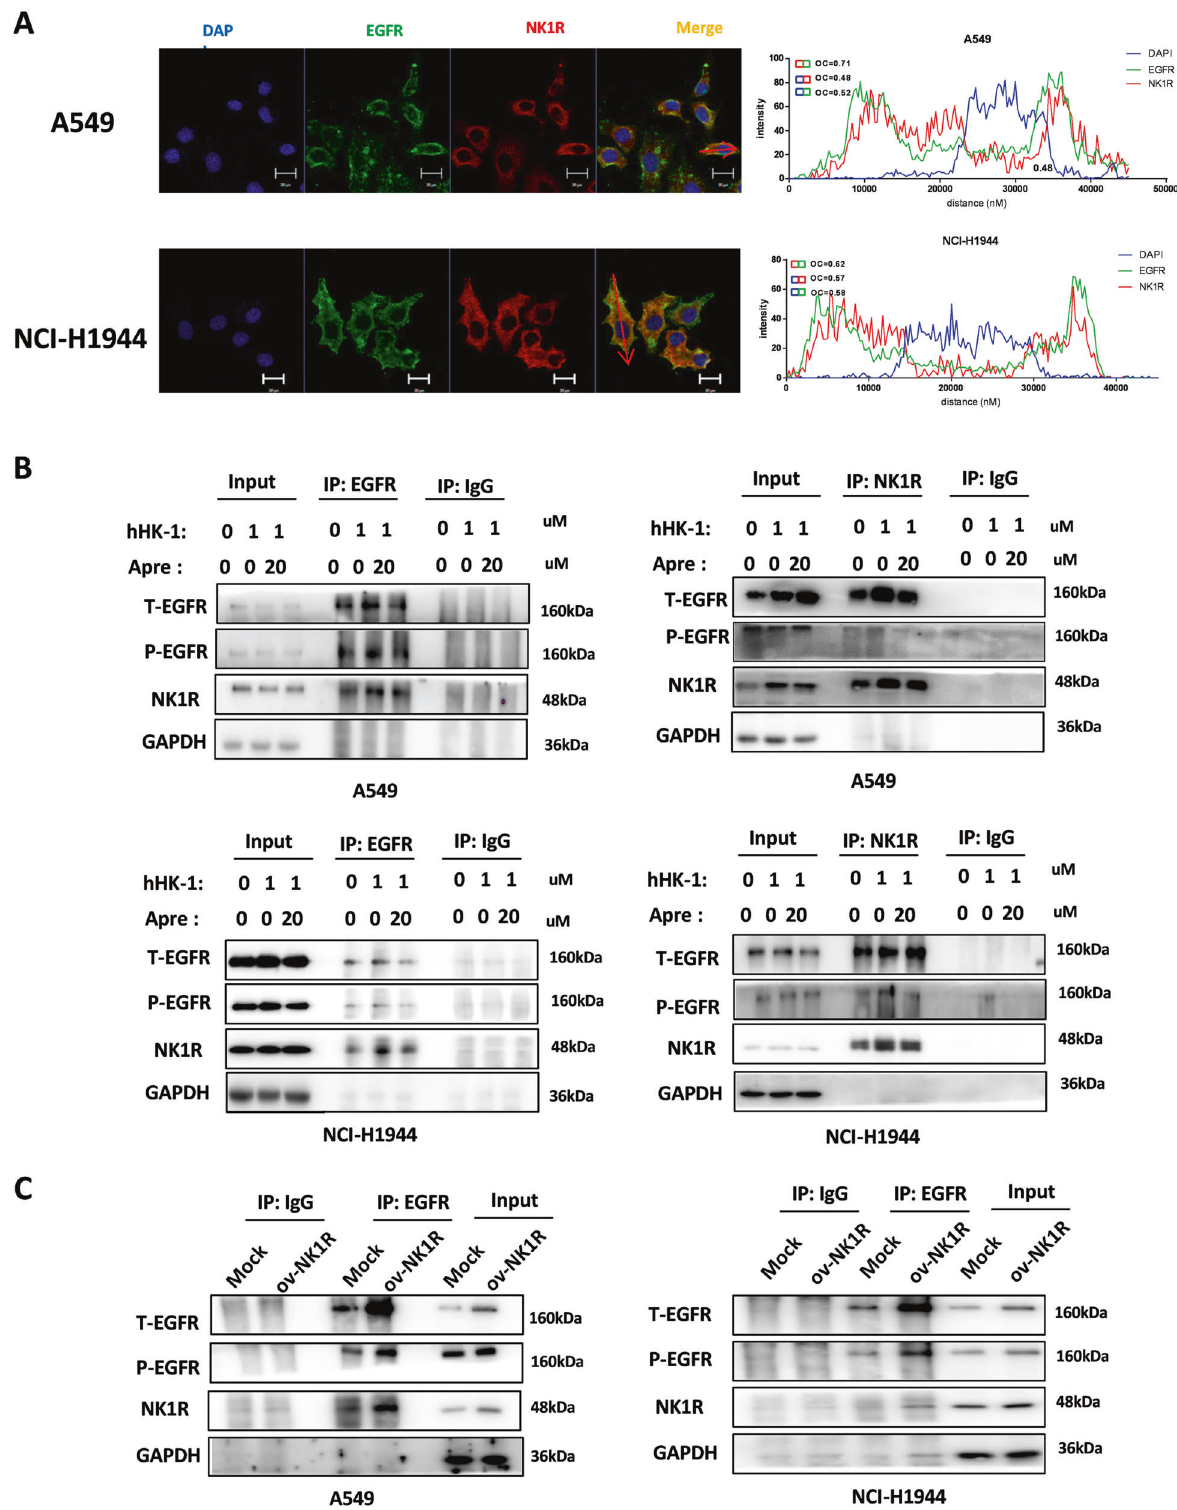
Fig. 6 NK1R interacts with EGFR in NSCLC cells. A Confocal microscopy analysis to detect the colocalization of EGFR and NK1R in A549 and NCI-H1944. Green, EGFR; Red, NK1R; nucleus was stained by DAPI. Scale bar, 20 μ m. The plot pro fi le of fl uorescence intensity was used to show the overlap of the NK1R and EGFR. Overlap Coef fi cient (OC) was >0.6 as the indication colocalization, while overlap coef fi cient was <0.6 as the absence of colocalization. B Co-immunoprecipitation assay by the antibody of NK1R or EGFR to show NK1R-EGFR interaction in A549 and NCI- H1944 cell lines. Cells were treated with hHK-1 or aprepitant for 24 h to detect the effect on NK1R-EGFR interaction. C Overexpression of NK1R in A549 and NCI-H1944 enhanced NK1R-EGFR interaction in a co-immunoprecipitation assay.